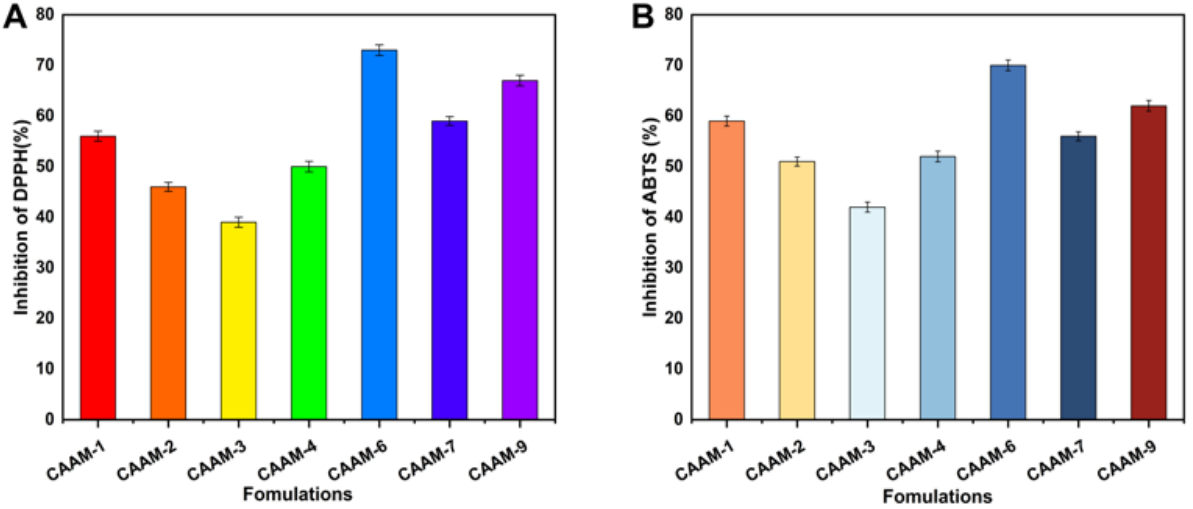
Figure 7. The antioxidant activity of hydrogels using DPPH ( A ) and ABTS ( B ) assay.